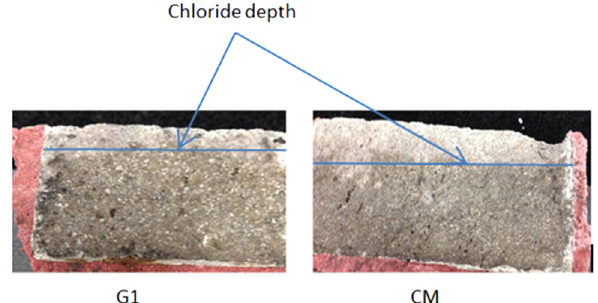
Figure 17: Chloride front of the control mix comparison to GO mix [ 114 ]